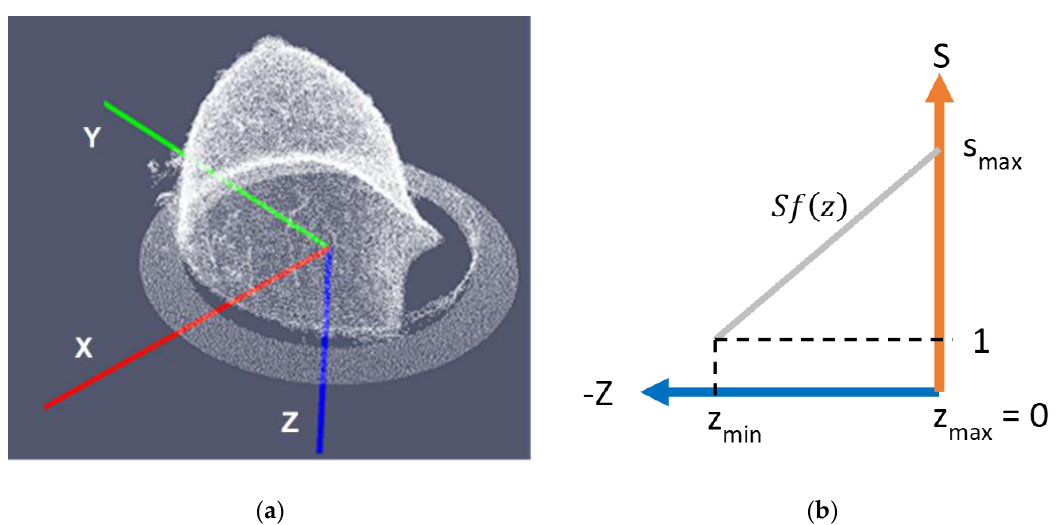
Figure 13. Linear stretching function Sf ( z ) : ( a ) the Wavelia reference coordinate system; ( b ) graphical representation of the Sf(z) function.